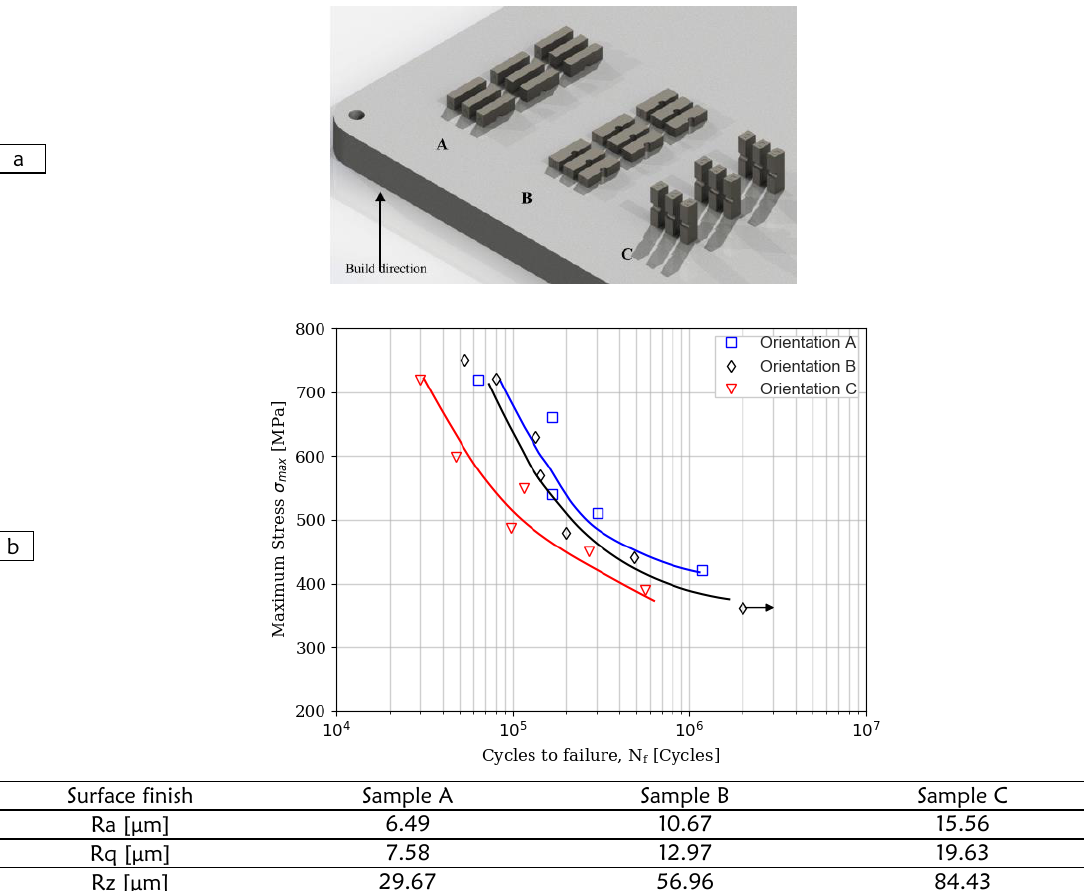
Figure 39: Effect of orientation on fatigue life of SLM IN718: (a) Orientation of specimen in SLM build chamber, (b) S-N curves of SLM IN718 specimens’ A, B and C and the corresponding average surface roughness corresponding to specimen orientation